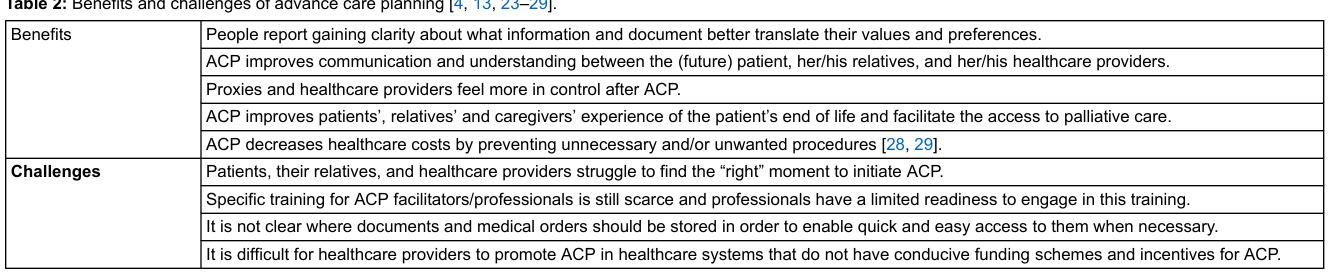
Table 2: Benefits and challenges of advance care planning [4, 13, 23–29]. Benefits People report gaining clarity about what information and document better translate their values and